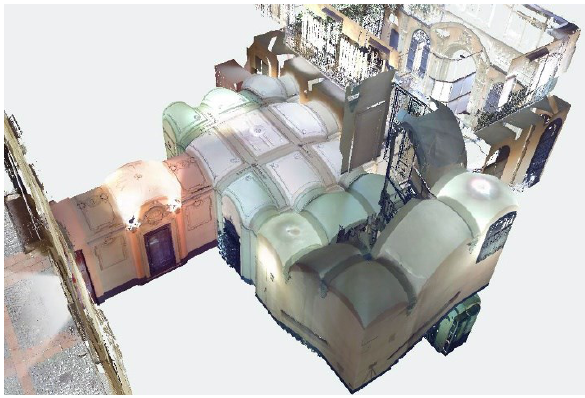
Figure 10. The result of the union of all clouds of